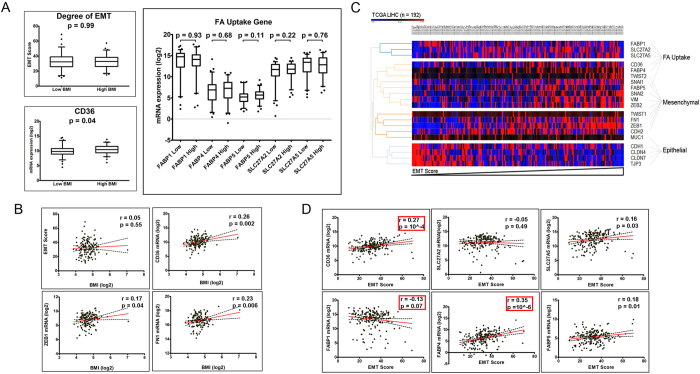
Fatty acid uptake and EMT markers in TCGA liver cancer dataset.(A) 158 samples from the TCGA LIHC database were analyzed to determine the effect of patient’s BMI on EMT and FA uptake gene expression. Box plot showing comparison of EMT scores, mRNA expression levels of hepatic FA uptake genes and CD36 in groups of patients with BMI < 25 (Low BMI, n = 75) or ≥25 (High BMI, n = 83) P-values indicate significance levels from two-tailed Student’s T-test. (B) Scatter plots showing correlation between BMI (X-axis) and EMT score, CD36, ZEB1 or FN1 (Y-axis). The solid red line indicates linear fit, with 95% confidence intervals indicated by dotted black lines. r indicates Pearson’s correlation coefficient and p-values indicate significance of correlation (two-tailed), with the red boxes marking significant associations from the multivariate regression analysis. (C) Heatmap showing relative expression levels of hepatic fatty acid uptake genes and EMT genes in the TCGA liver cancer dataset. Gene clusters (vertical axis) were obtained by hierarchical clustering and samples (horizontal axis) were ordered according to the EMT score. (D) Scatter plot showing association between the fatty acid uptake genes (Y-axis) and EMT score (X-axis) drawn from 158 patient samples in the TCGA dataset. The solid red line indicates linear fit, with 95% confidence intervals indicated by dotted black lines. r indicates Pearson’s correlation coefficient and p-values indicate significance of correlation (two-tailed), with the red boxes marking significant associations from the multivariate regression analysis (n = 158). Clinical data for each patient is available in Supplementary Table 1 (Bonferroni adjusted p-value cut-off for the analysis = 0.0016).